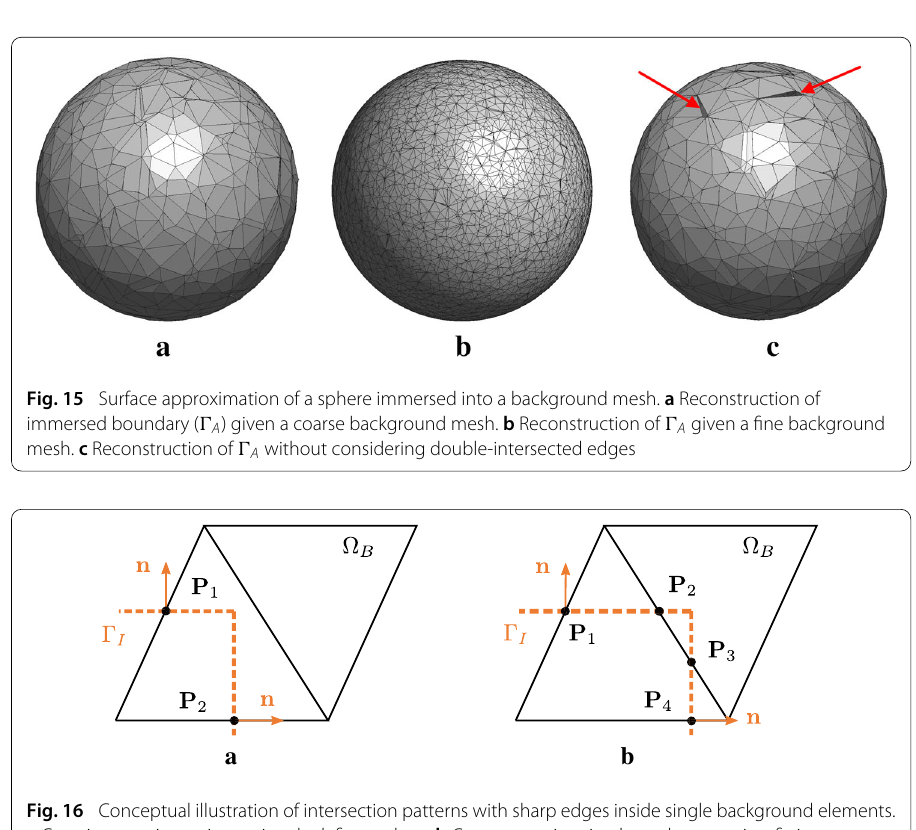
to a locally unsuccessful approximation of the cutting plane (see Fig. 15c). From the pre- vious results, one can conclude, that the presented algorithm is able to handle immersed geometries with slight